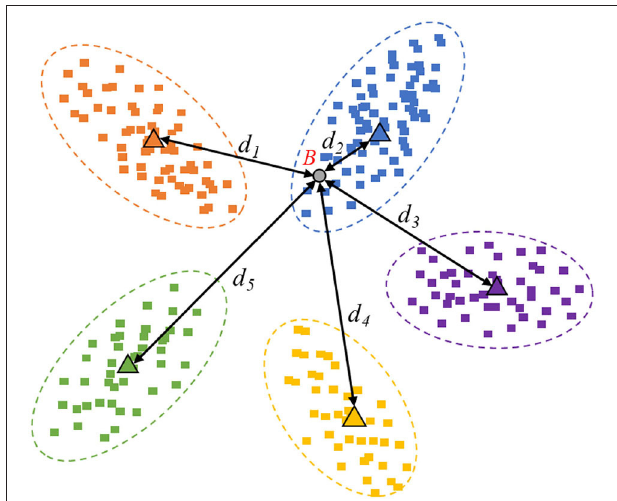
FIGURE 4 | Image example with low information